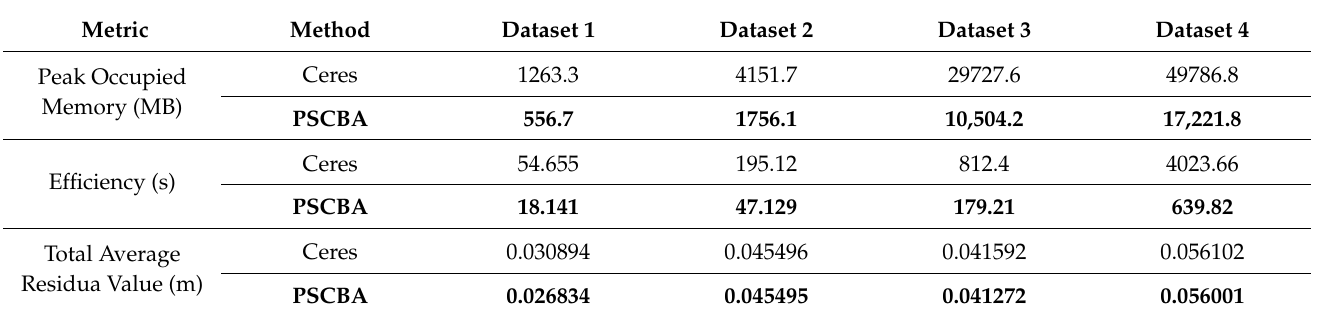
Table 3. Bundle adjustment details metric.